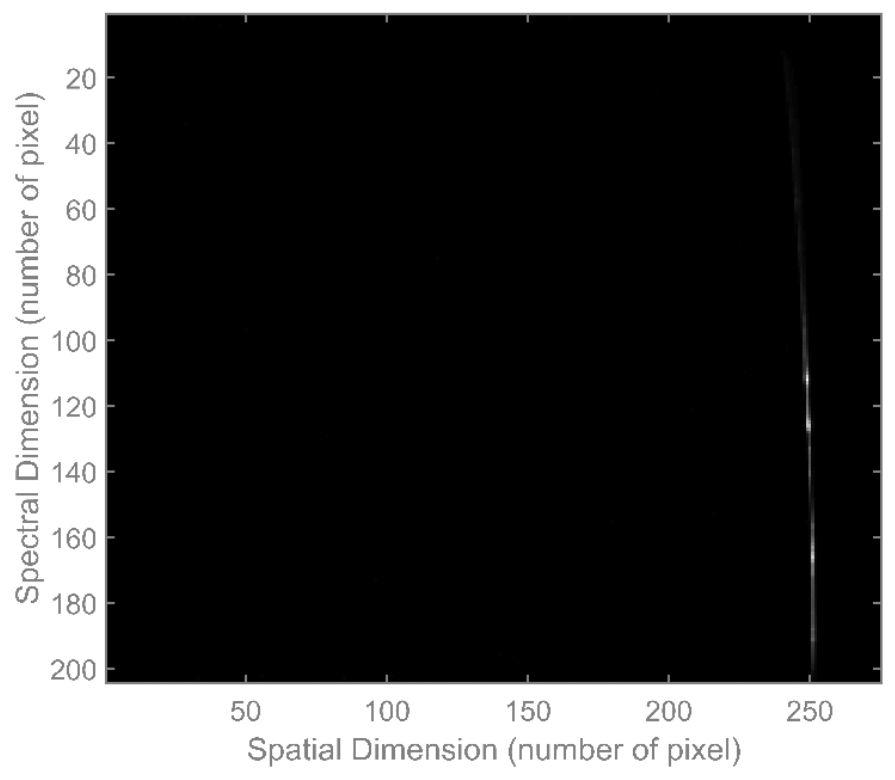
Figure 8. Response of HARIS at the geometric calibration of 88.57 ° . As shown, the instrument response is a curve in the spectral dimension before the calibration is performed.